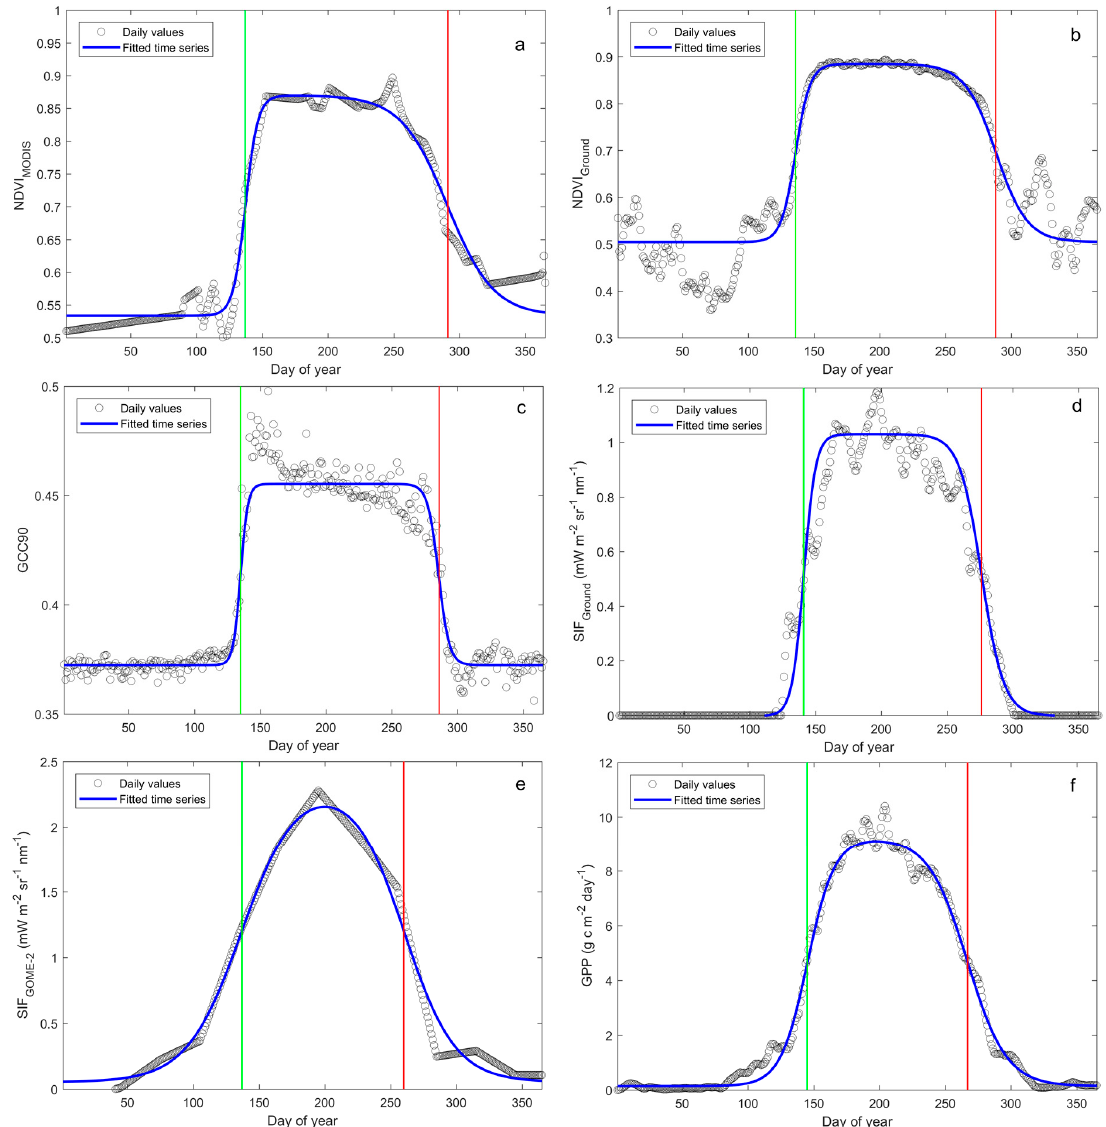
Figure 2. Overview of the different time series at Harvard Forest site in 2014 including MODIS NDVI (NDVI MODIS ) ( a ); ground-based NDVI (NDVI Ground ) ( b ); the 90th percentile of: green chromatic coordinates (GCC90) ( c ); ground-based SIF (SIF Ground ) ( d ); GOME-2 SIF (SIF GOME-2 ) ( e ); and GPP provided by eddy covariance technique ( f ). The green and red lines represent dates of middle of spring (S2) and autumn (A2), respectively. All the time series are linearly interpolated into a daily time step.